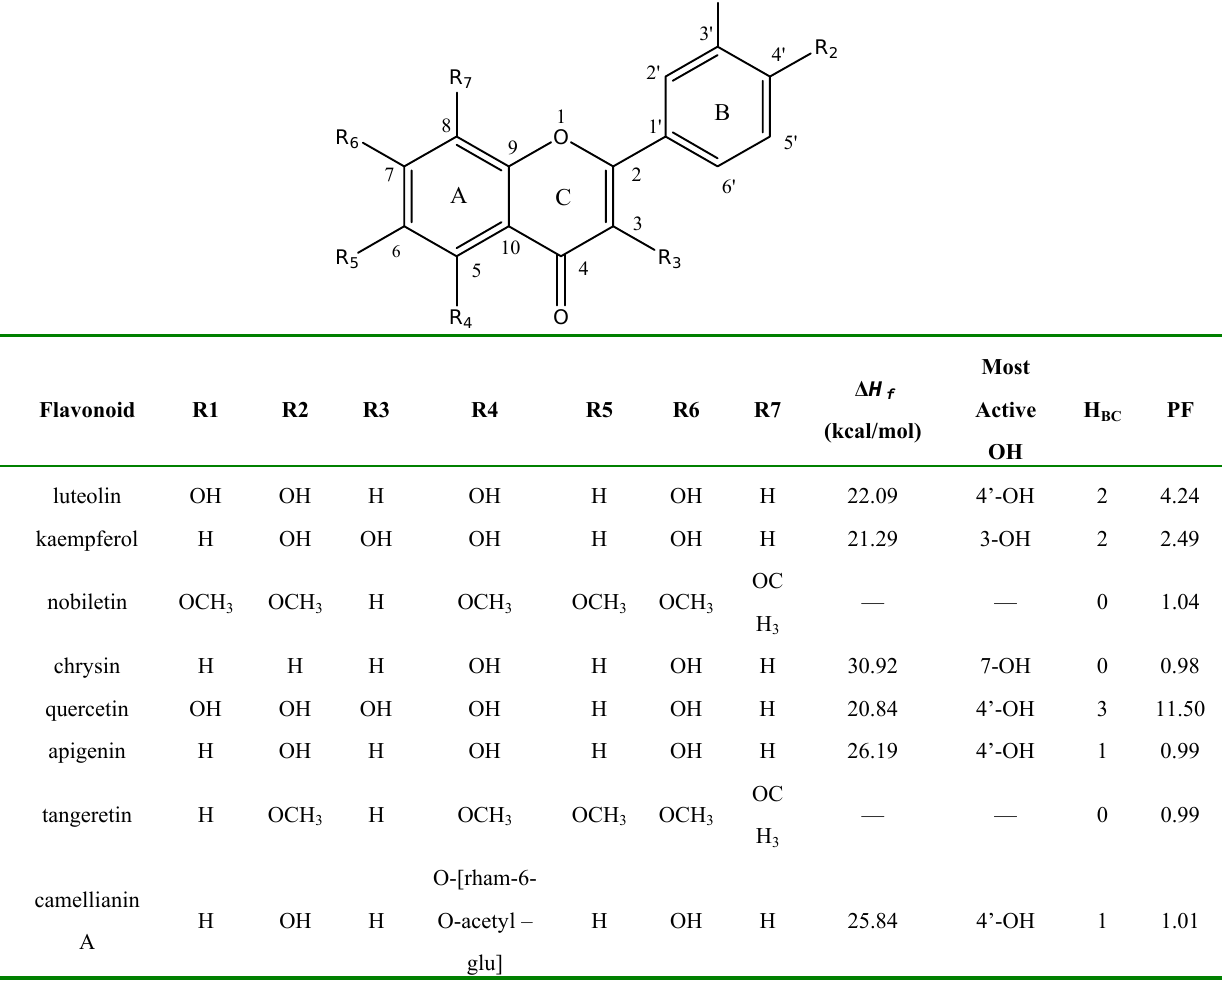
Table 1. Chemical structures, descriptors and antioxidant activity of some flavones and